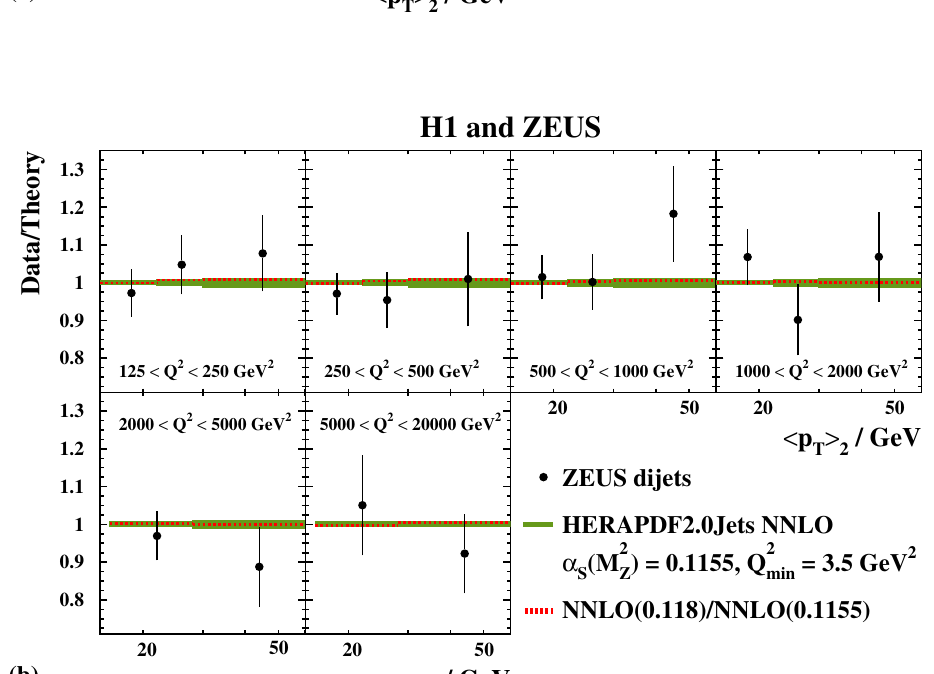
Fig. 20 a Differential dijet-cross-section predictions, d σ/ d (cid:5) p T (cid:6) 2 , based on HERAPDF2.0Jets NNLO with α s ( M 2 of Q 2 between 125 and 20000GeV 2 compared to ZEUS data [12]. The variable (cid:5) p T (cid:6) 2 denotes the average p T of the two jets. Only data used in the fit are shown. b Measured dijet cross sections divided by predictions based on HERAPDF2.0Jets NNLO. The bands represent